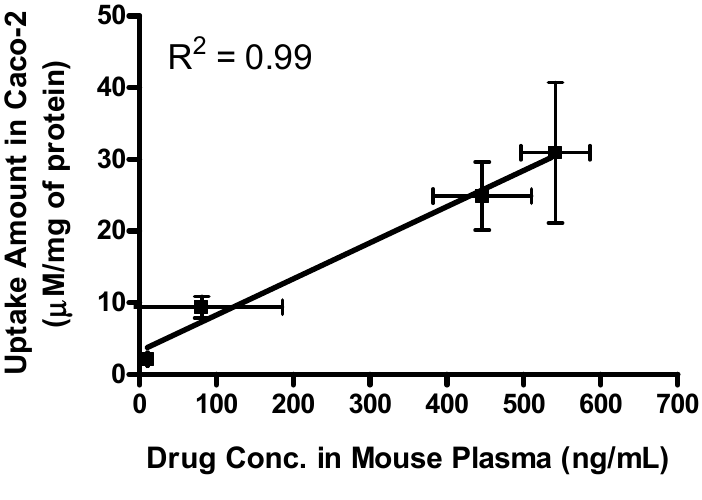
Figure 6. The correlation between the drug concentration in mouse plasma after in situ perfusion and the uptake amount of dipeptide prodrugs and their parents, floxuridine and gemcitabine, in Caco-2 cells. Values are the mean ± SD, n =